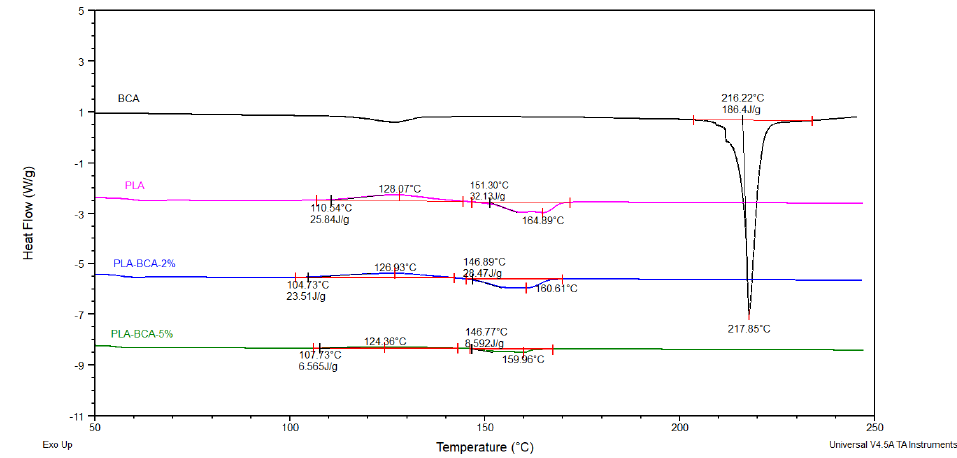
Figure 2. DSC curves of: biochanin A, electrospun PLA fibers, PLA-BCA-2% and PLA-BCA-5%.